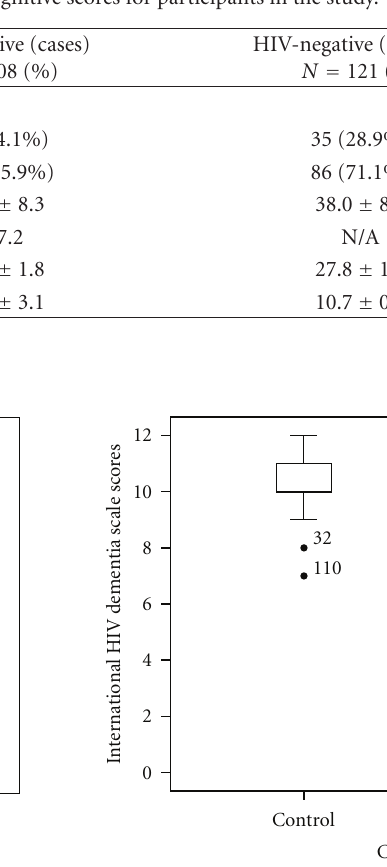
Table 1: Baseline data and cognitive scores for participants in the study.